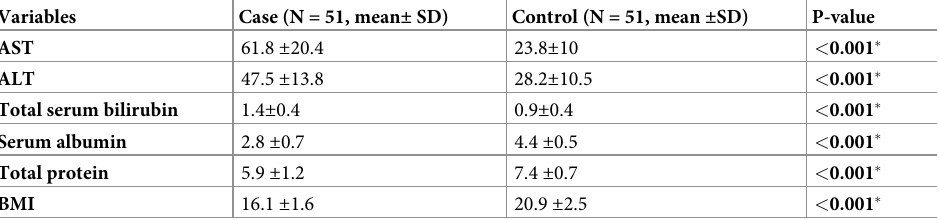
between VL patients and apparently healthy controls Assessment of malnutrition status among VL patients and control groups was performed using anthropometric techniques and biochemical tests (serum albumin and total protein) through standard kit measurement method. There was a statistically significant reduction of serum albumin level in VL patients as compared to control groups (P < 0.001). Similarly, there was a statistically significant reduction of serum total protein in VL patients as compared to Table 3. Comparison of levels of AST, ALT, total serum bilirubin, serum albumin and total serum protein using independent sample t-test between VL patients and health controls.